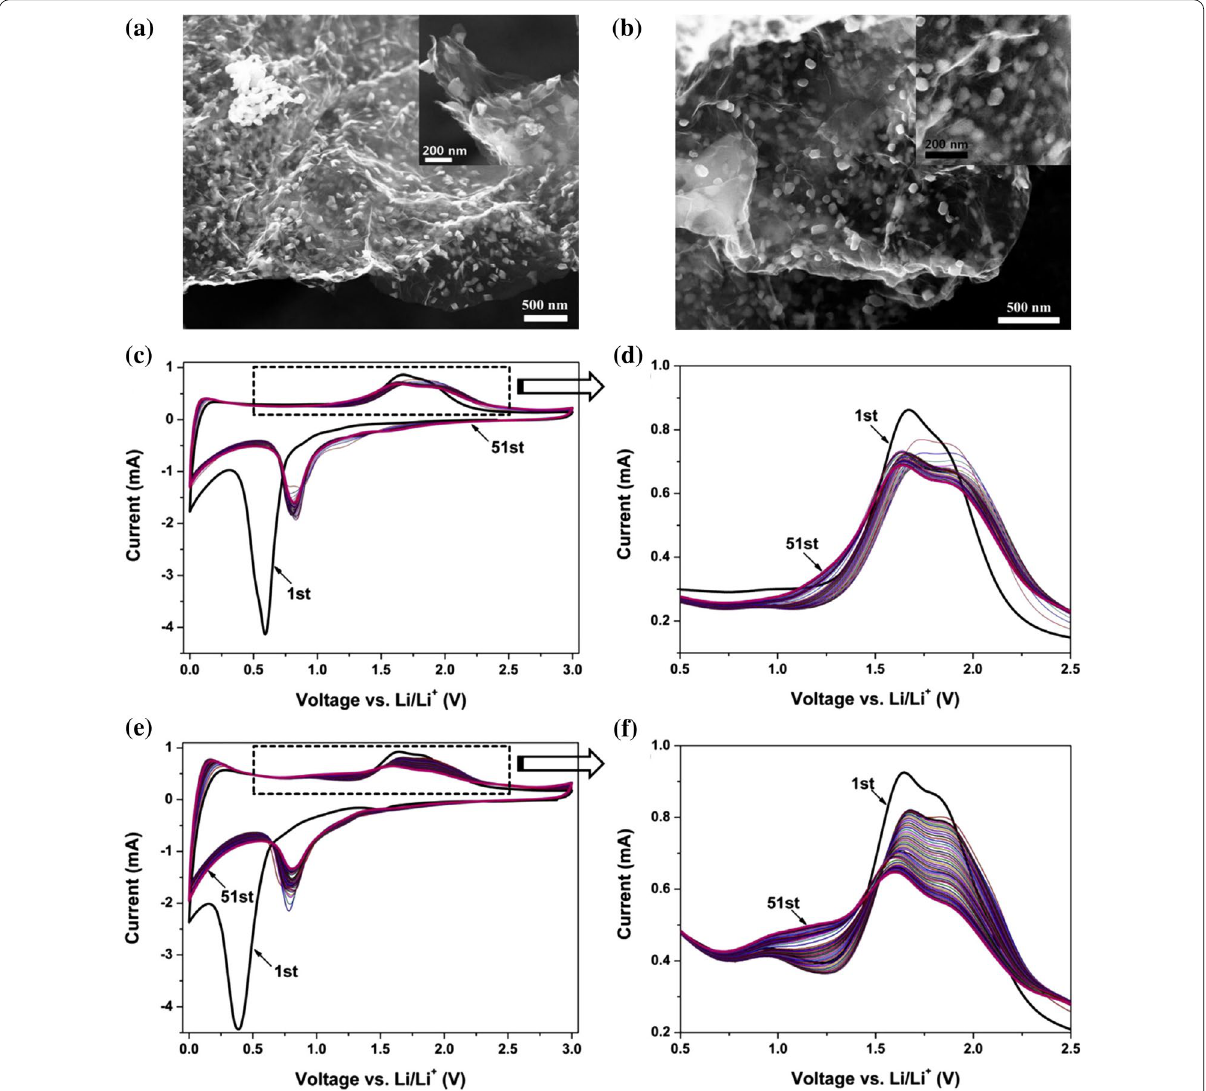
Fig. 1 SEM images of a Fe 2 O 3 /graphene and b K-FeO/graphene, and the inset in ( a , b ) are their magnified images, respectively. Repeated cyclic voltammograms of c , d the Fe 2 O 3 /graphene electrode and e , f the K-FeO/graphene electrode. Two electrodes were continually scanned for the 51st cycles with a potential sweep rate of 0.5 mV s − 1 . Reprinted with Permission from [11]. Copyright, Elsevier